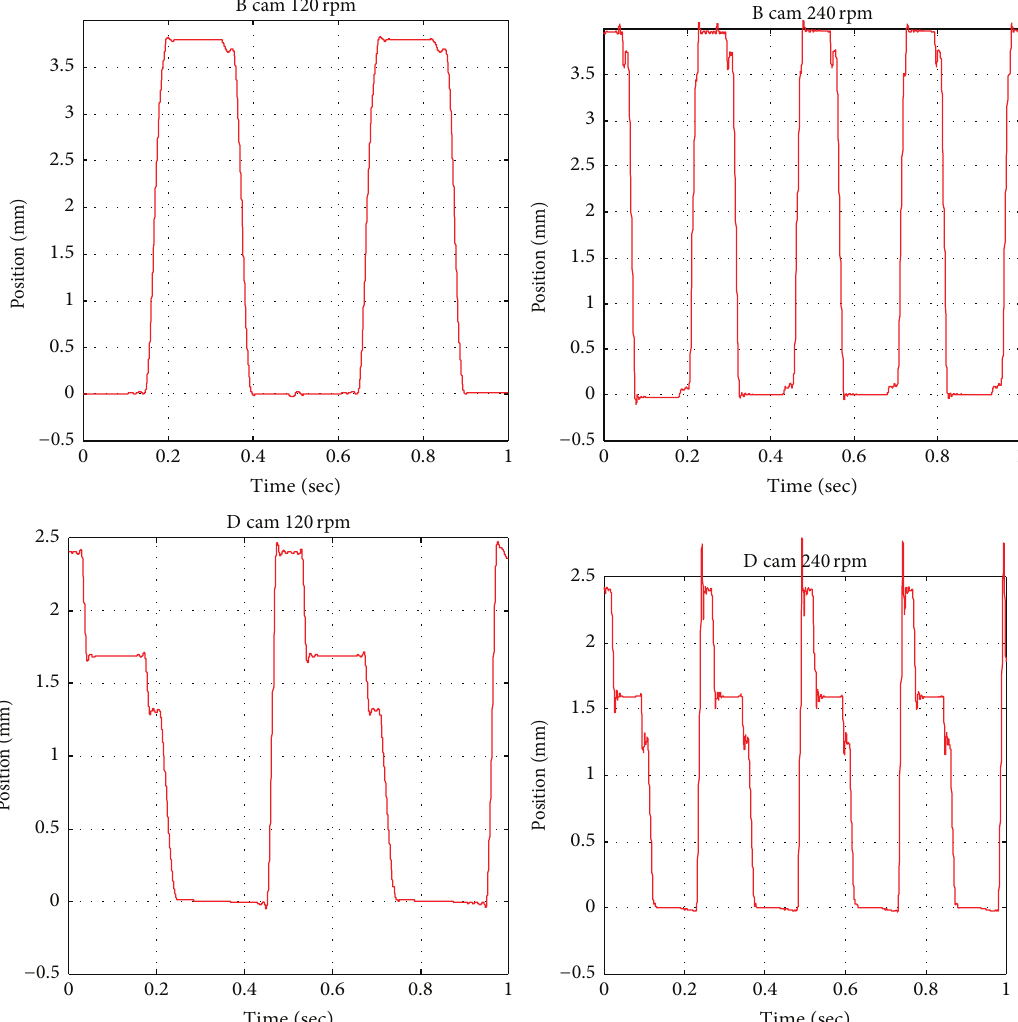
Figure 5: Displacements of the fixtures B and D for two different